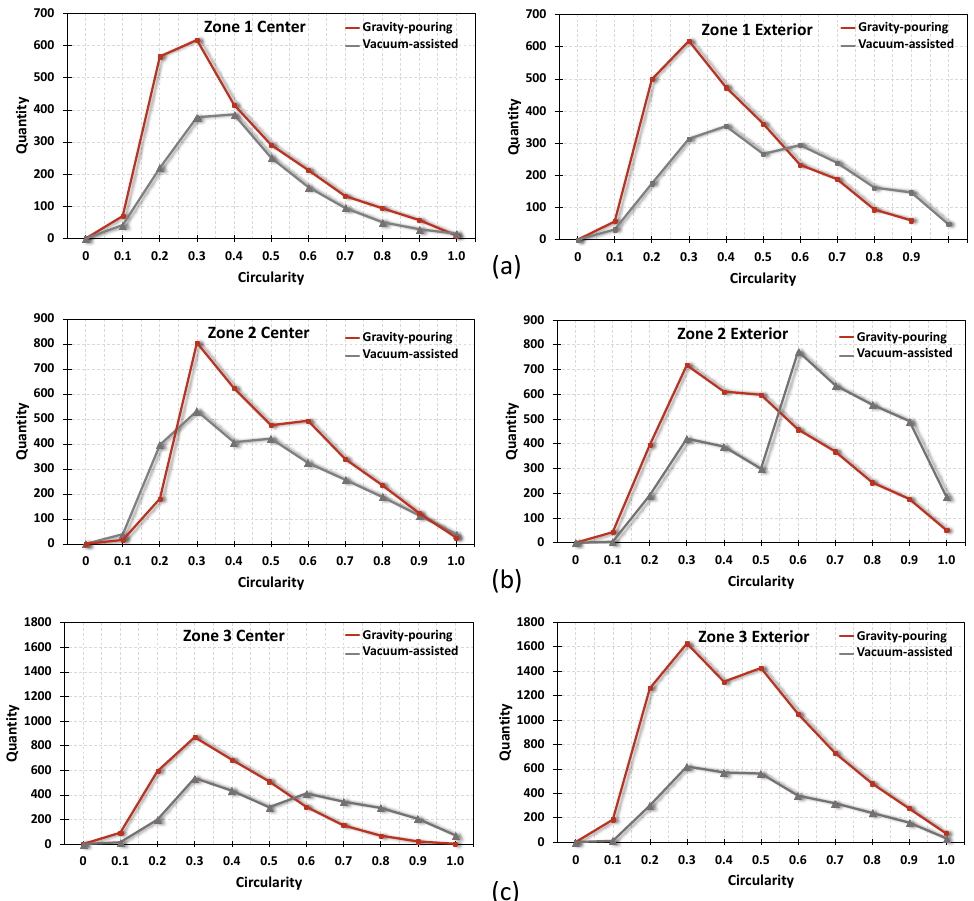
Figure 13. Statistical data on pore circularity for each area and location. ( a ) Zone I, ( b ) zone II and ( c ) zone III.